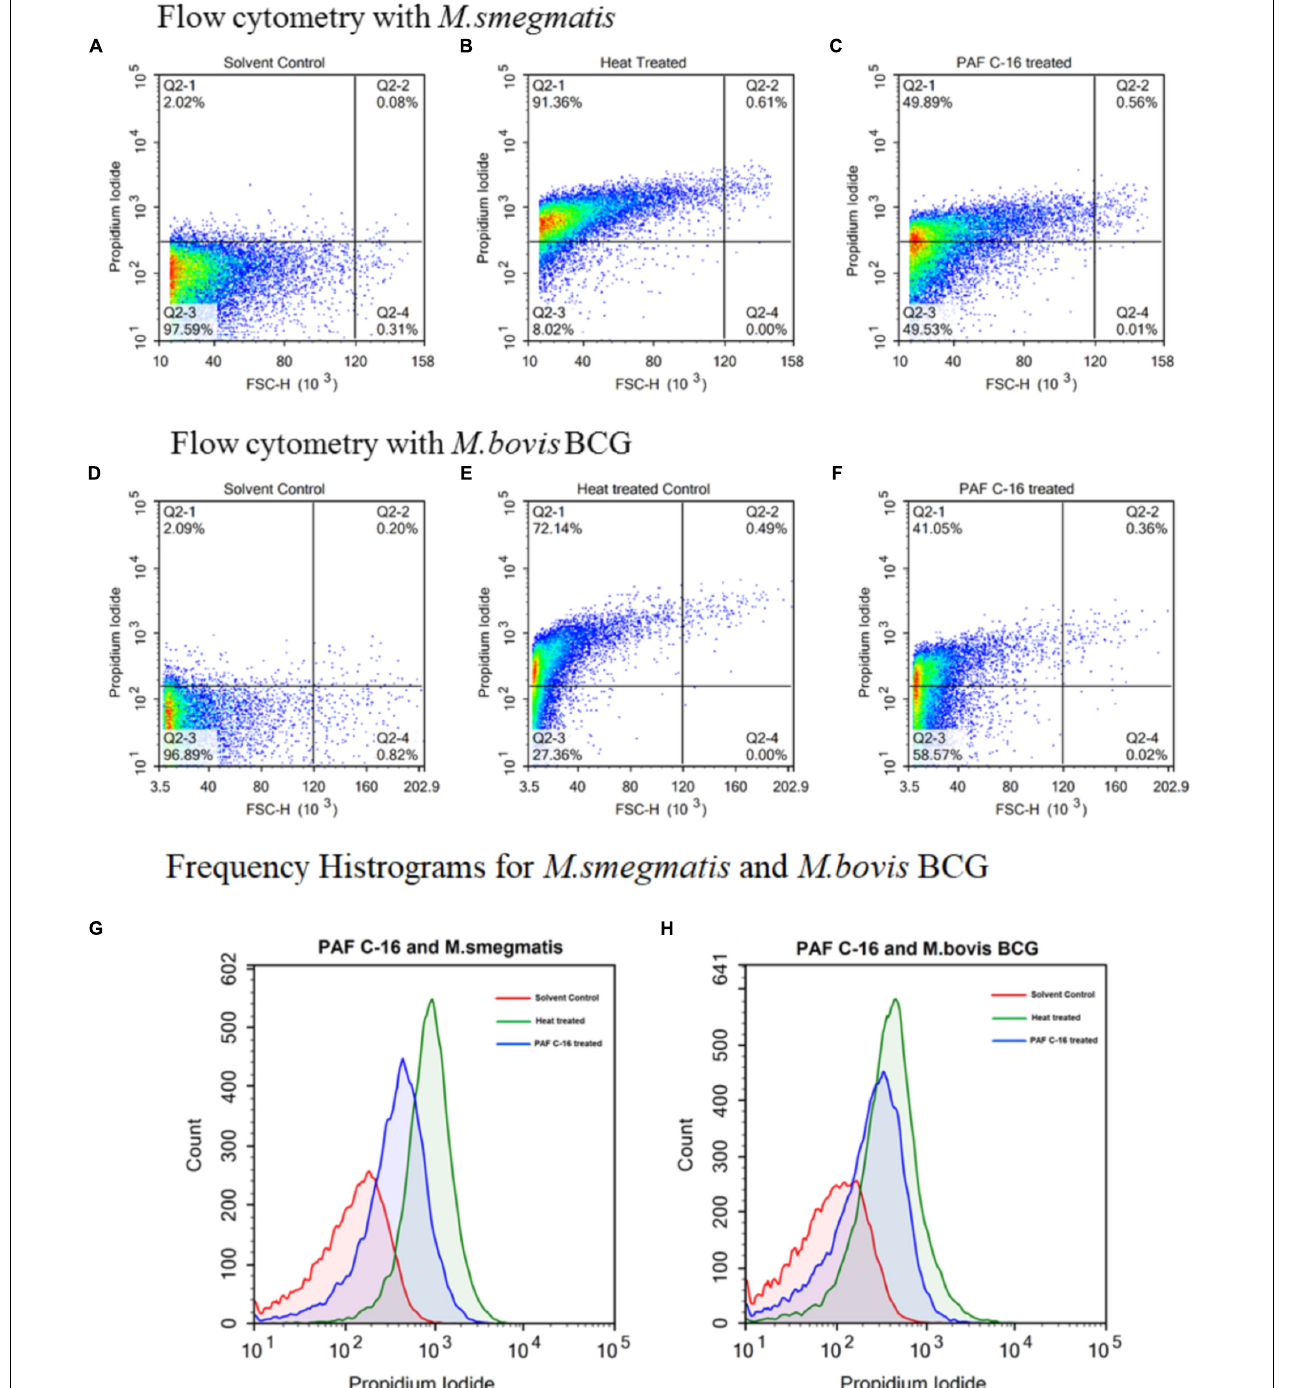
FIGURE 8 | Flow cytometric analysis to determine cell membrane integrity of PAF C-16 treated M. smegmatis and M. bovis BCG. Flow cytometry density plots for M. smegmatis (A–C) and M. bovis BCG (D–F) treated with PAF C-16 or solvent control for 2 h and heat killed positive control after staining with propidium iodide. Density plots (A,D) are solvent treated (10 µ l/ml ethanol) negative control, density plots (B,E) are heat treated (100 ◦ C, 10 min) positive control, density plots (C,F) are PAF C-16 treated (100 µ g/ml) test conditions. Each plot shows percentage of unstained and PI stained bacteria for different conditions. The difference in fluorescence intensity for PAF C-16 treated test, solvent treated negative control and heat treated positive control are shown using frequency histogram overlay for M. smegmatis (G) and M. bovis BCG (H) . The blue color histograms represent PAF C-16 treated bacteria, red color is for solvent treated negative control and green color represents heat treated positive